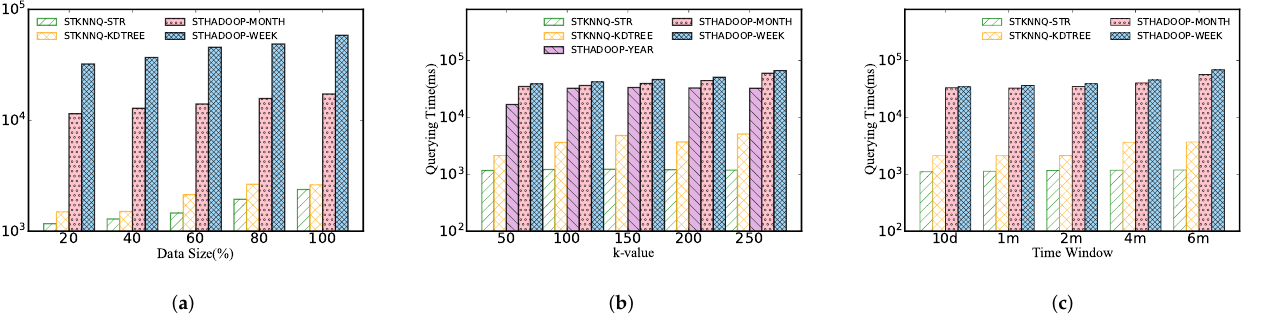
Figure 11. Performance of spatio-temporal kNN query. ( a ) Data size. ( b ) K -value. ( c ) Time